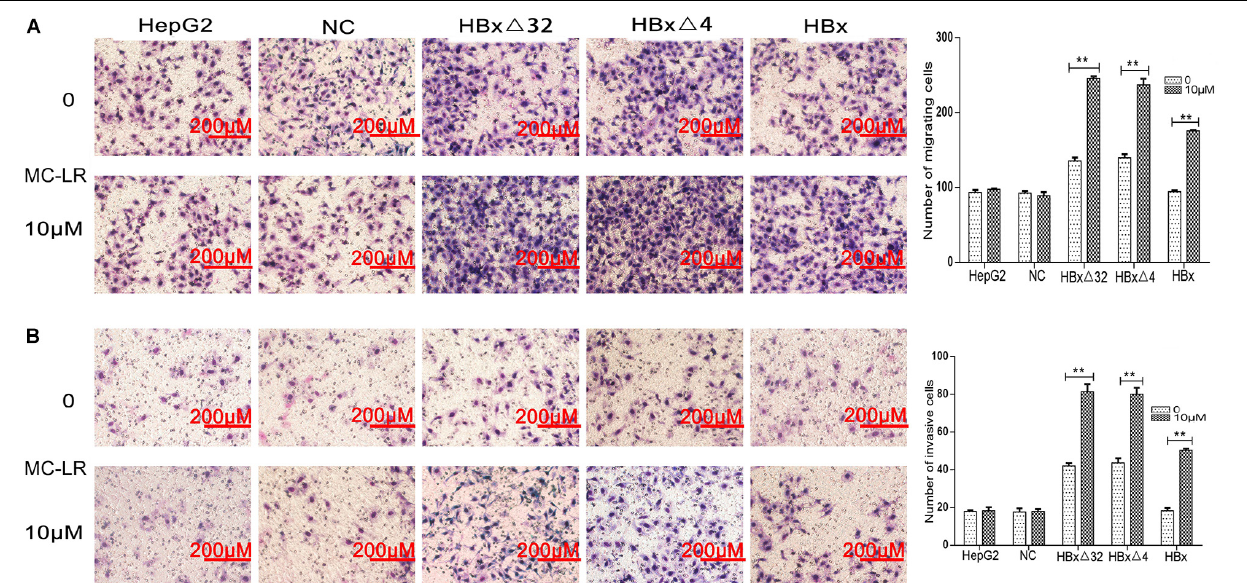
FIGURE 4 | Effect of MC-LR and ctHBx on the migration and invasion abilities of HepG2 cells. A transwell assay was performed to investigate the effect of MC-LR and ctHBx on the migration and invasion of HepG2 cells. (A) The results showed that the migration between HBx (cid:49) 32, HBx (cid:49) 4, and HBx groups were statistically difference ( F = 52.074, P = 0.001), HBx (cid:49) 32 and HBx (cid:49) 4 groups were stronger than HBx group (HBx (cid:49) 32 vs. HBx P < 0.001; HBx (cid:49) 4 vs. HBx P < 0.001). (B) When comparing the invasion, the statistical differences were also found ( F = 31.177, P = 0.001), HBx (cid:49) 32 and HBx (cid:49) 4 groups were stronger than HBx group (HBx (cid:49) 32 vs. HBx P < 0.0001; HBx (cid:49) 4 vs. HBx P = 0.001). Bar graphs indicate means ± standard deviation from three independent experiments. ** P < 0.01 vs. 0 µ M MC-LR.